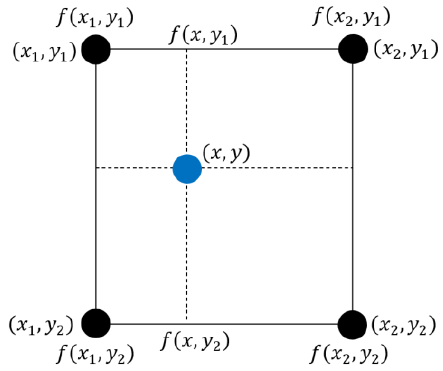
Figure 8. Bilinear interpolation